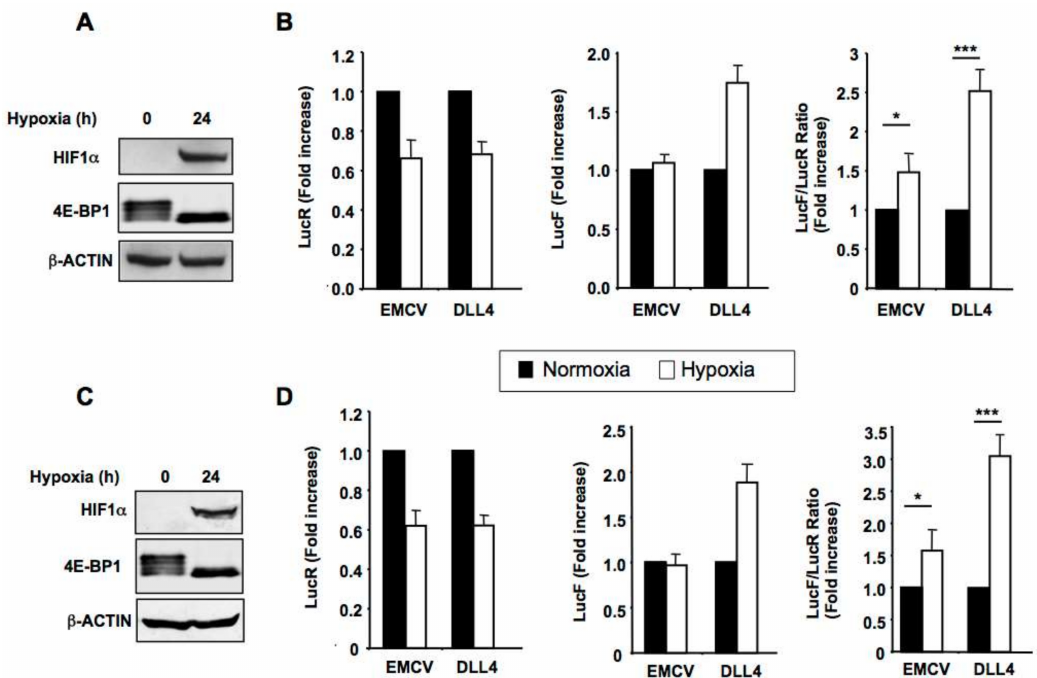
Figure 2. The DLL4 IRES is activated by hypoxia. HeLa ( A , B ) or HUVEC endothelial cells ( C , D ) cells were transfected by bicistronic constructs containing either the EMCV or the DLL4 IRES and submitted to 24 h hypoxia. ( A , C ) Hypoxia was confirmed through verifying both expression induction of HIF-1 α and 4E-BP1 dephosphorylation (lower band visible at 24 h of hypoxia) by western blotting. β -ACTIN was used as a loading control. ( B , D ) Relative luciferase activities LucR, LucF or LucF/LucFR ratio (fold increase) under normoxia (black bars) and hypoxia (white bars) in HeLa ( B ) or HUVEC ( D ) cells. Results represent the means of three independent experiments ( ± SEM), * p < 0.05, *** p <